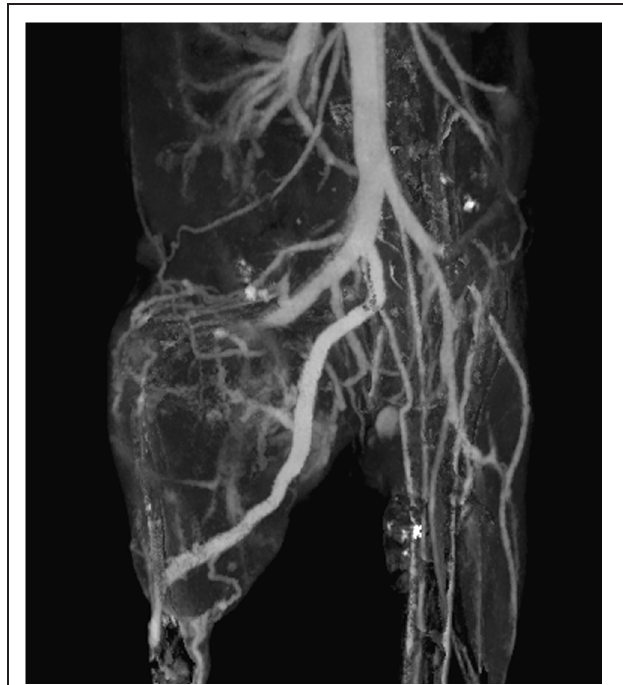
FIGURE 6 | Coronal maximum intensity projection of intravascular iodine in a mouse with a soft-tissue sarcoma in the right hindlimb. Micro-CT imaging (88 µ m voxel size) was performed immediately after injection of a liposomal iodine contrast